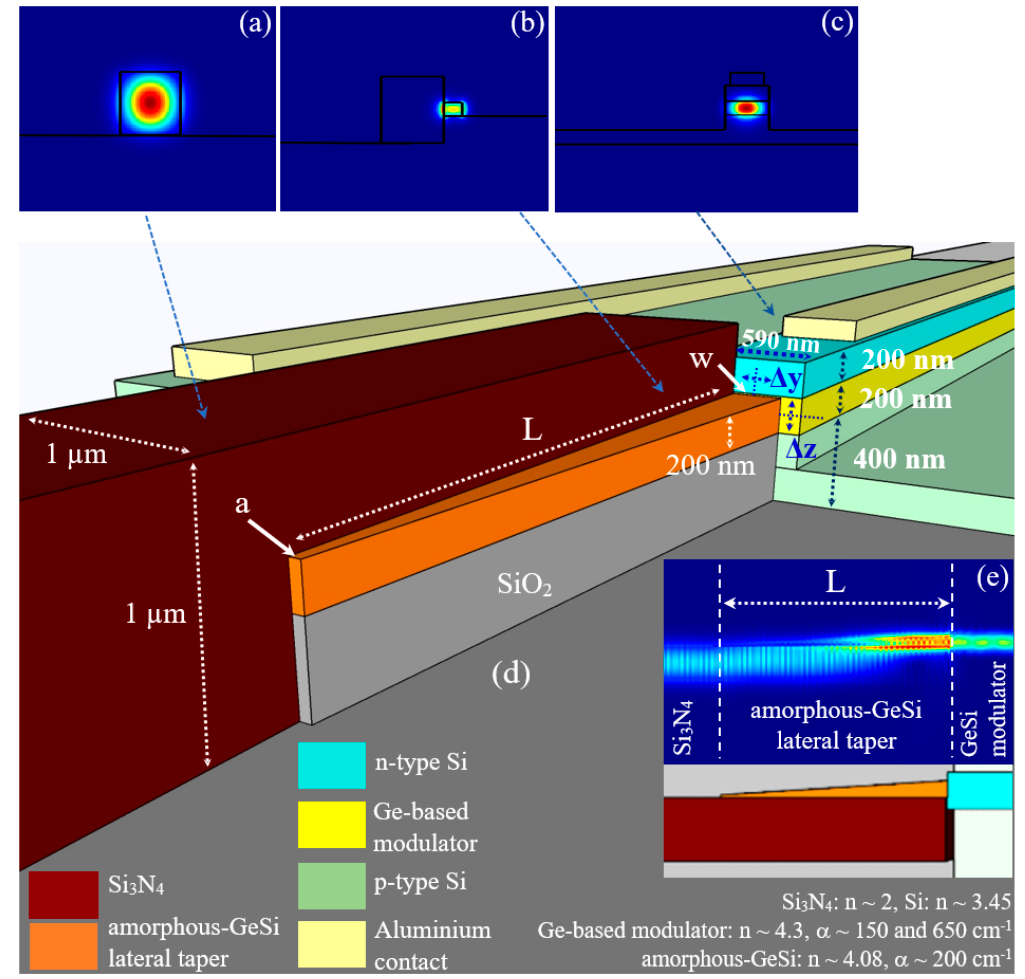
Figure 1. The fundamental optical mode of ( a ) 1 µm high and 1 µm wide Si 3 N 4 waveguide, ( b ) amorphous-GeSi lateral taper, and ( c ) 200 nm high and 590 nm wide Ge-based Franz–Keldysh effect (FKE) optical modulator. ( d ) Schematic view of the proposed coupling structure. ( e ) Top view of optical propagation from the Si 3 N 4 waveguide via amorphous Ge 0.83 Si 0.17 taper to the Ge-based FKE optical modulator.